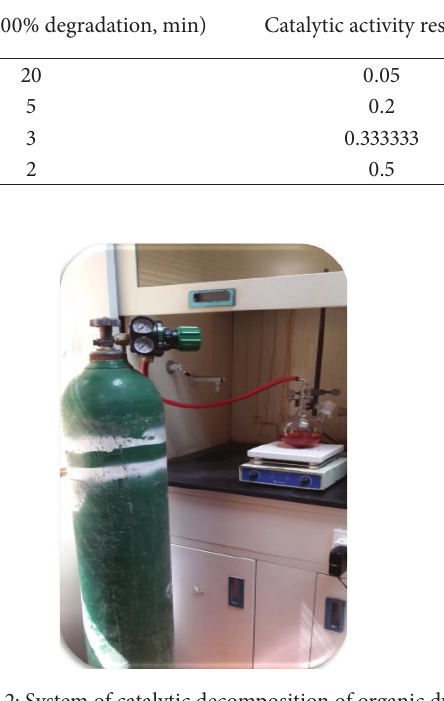
Figure 2: System of catalytic decomposition of organic dyes.